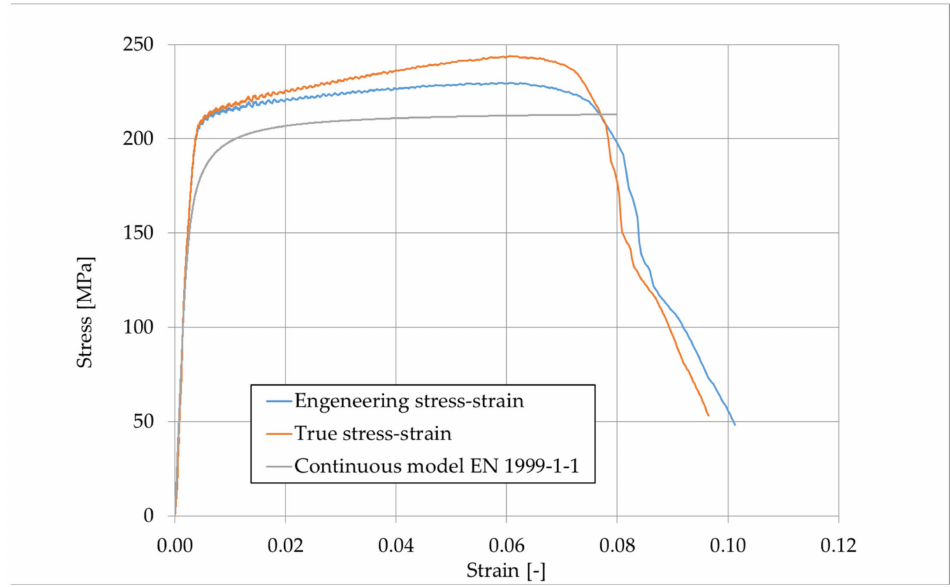
Figure 14. Engineering, true and standardised stress–strain curves for Al1.